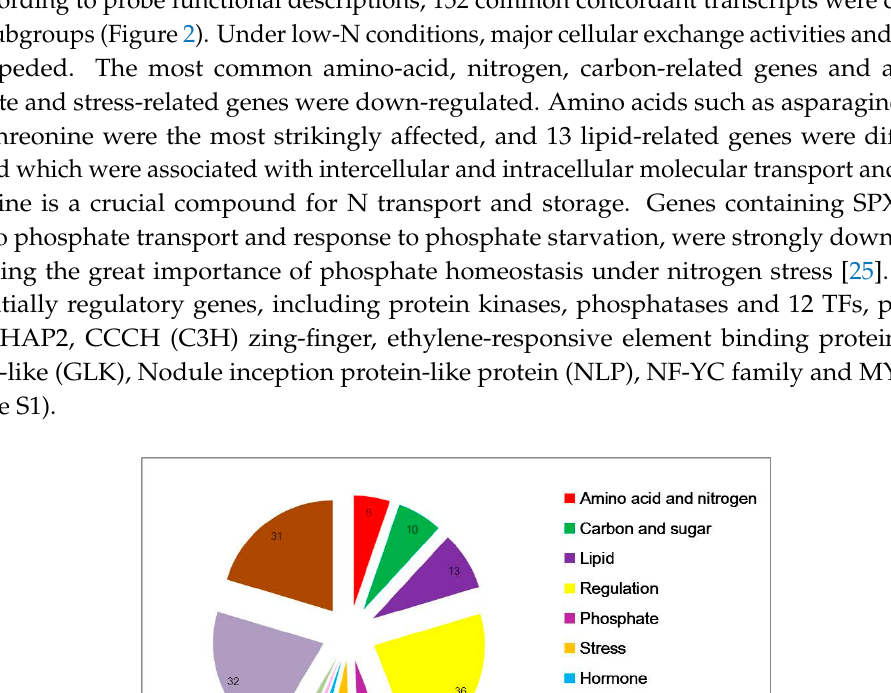
Figure 1. A Venn diagram of differential expressed genes and their common genes across two microarray datasets.